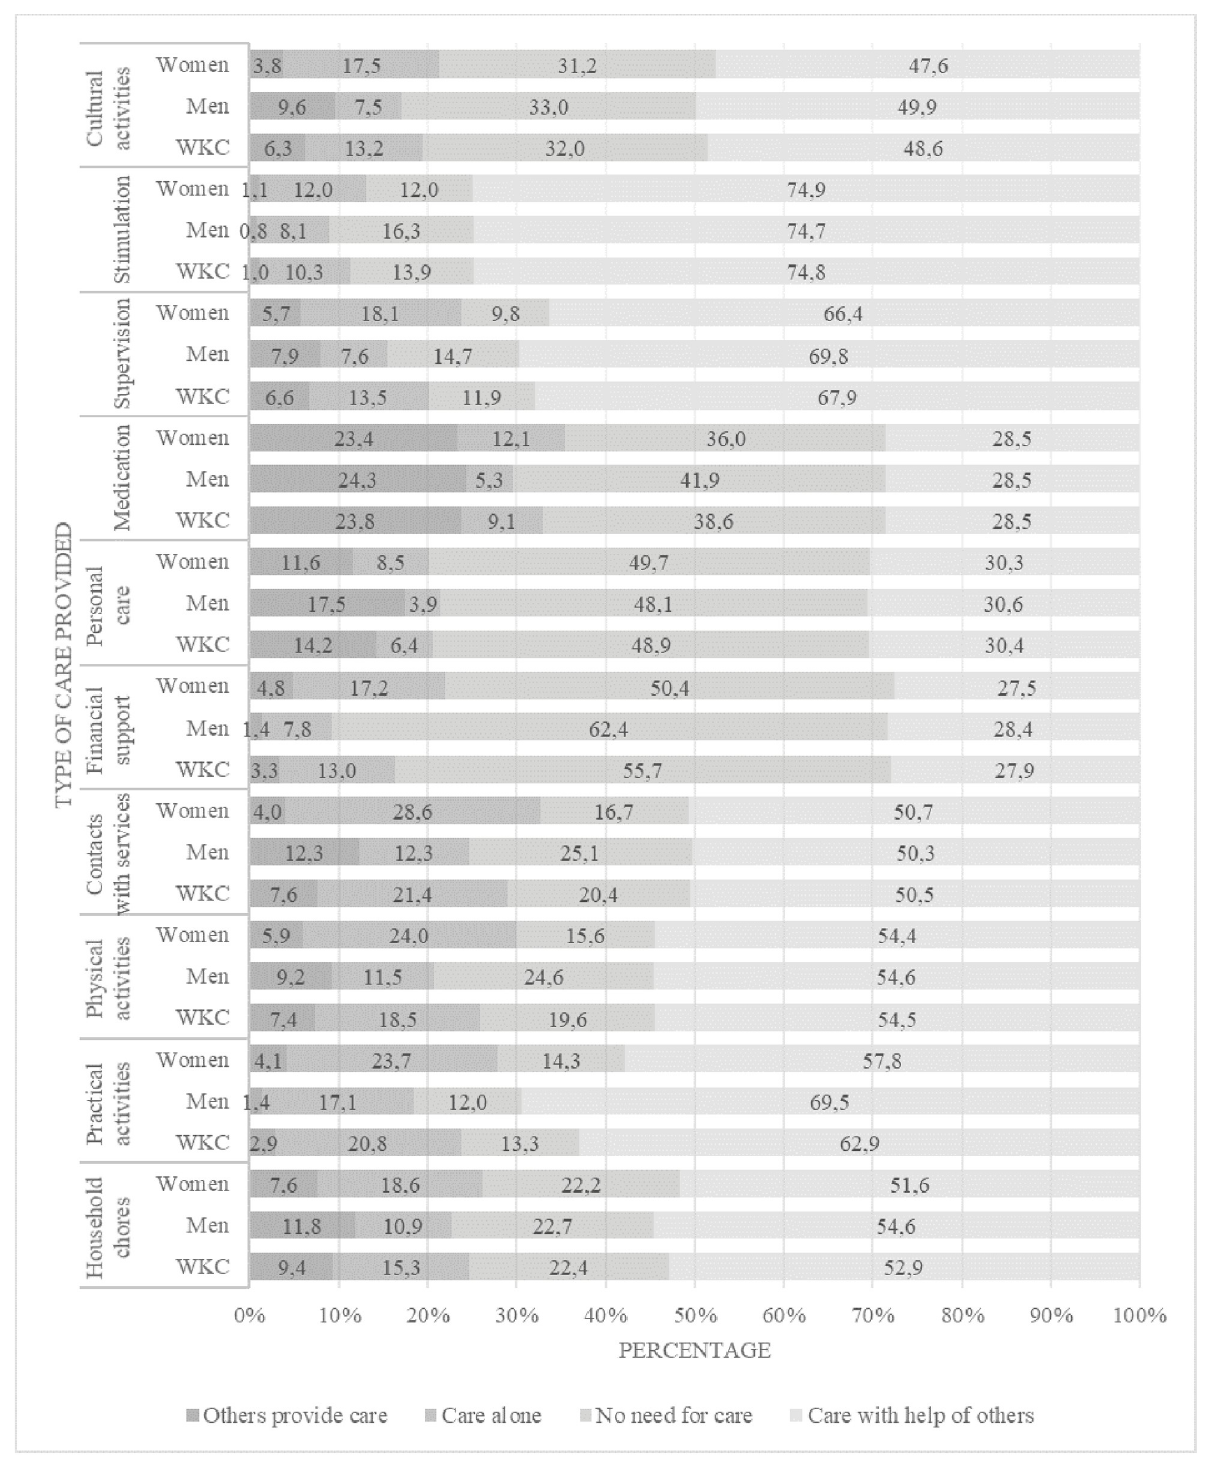
Fig 1. Type of care provided for ten domains of care for the total samples of working carers and by gender. Note: n for analysis varies between n = 817 and n = 797 due to internal missing data.